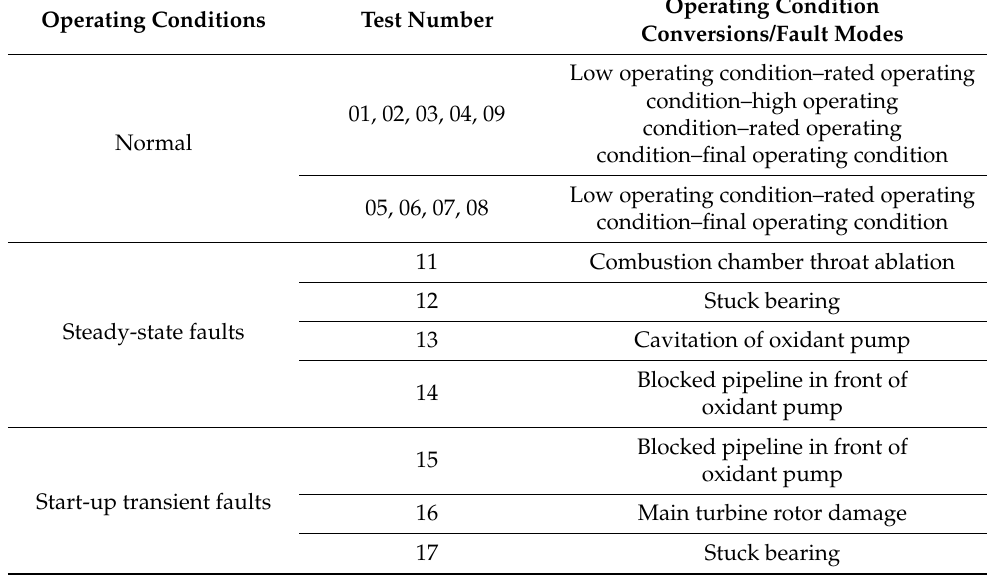
Table 1. The operating conditions of the